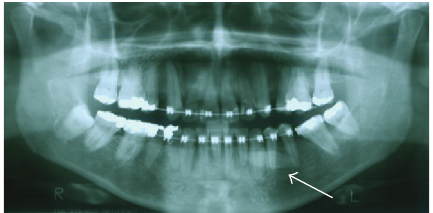
Figure 3: The last panoramic radiograph previously obtained for orthodontic purposes indicating the massive sialolith (arrow).